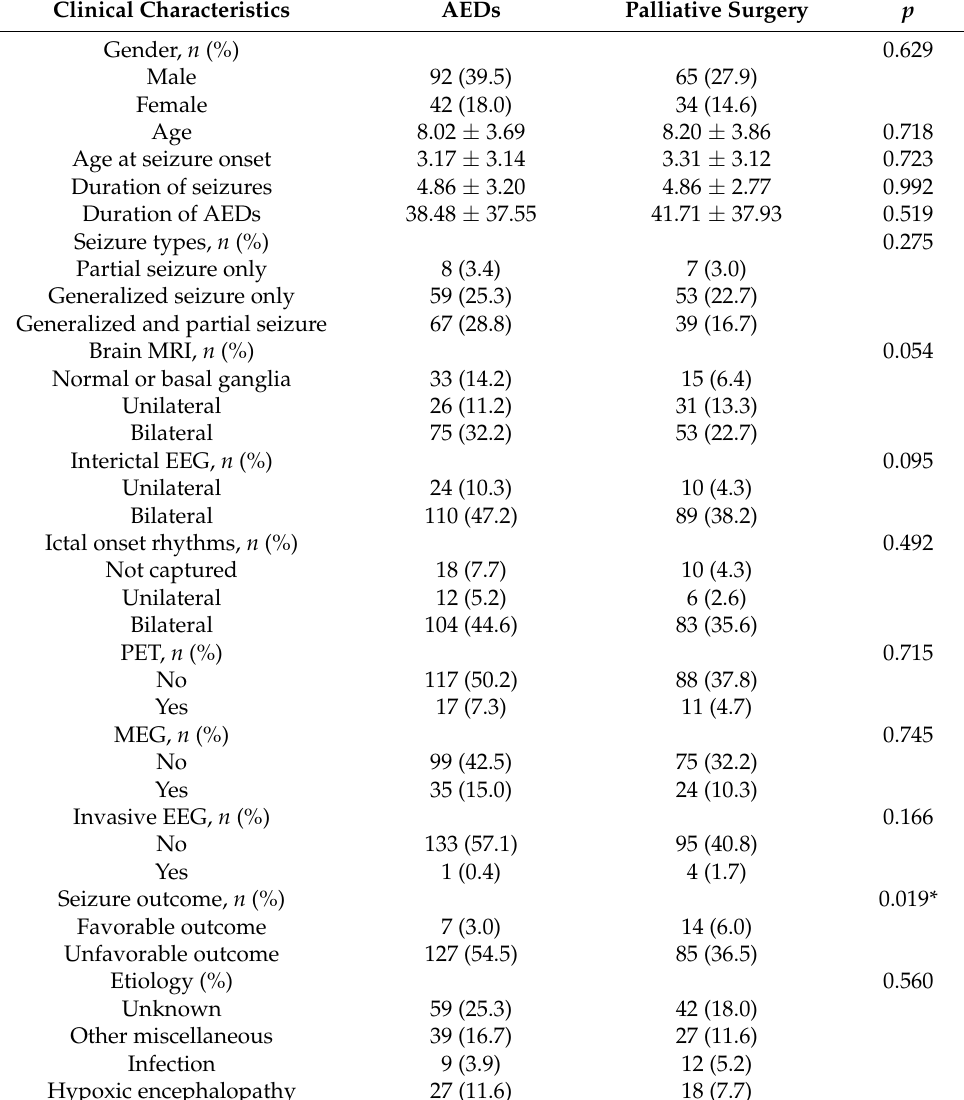
Table 1. The comparison of clinical characteristics between AEDs group and palliative surgery group ( n =